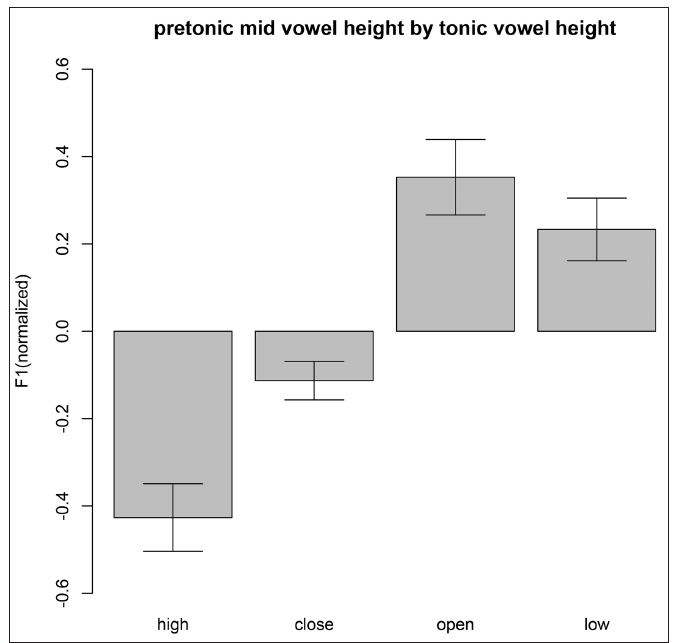
Figure 5: F1 of pretonic mid vowels of set B as a function of the tonic syllable’s phonological height. Error bars are 95% confidence